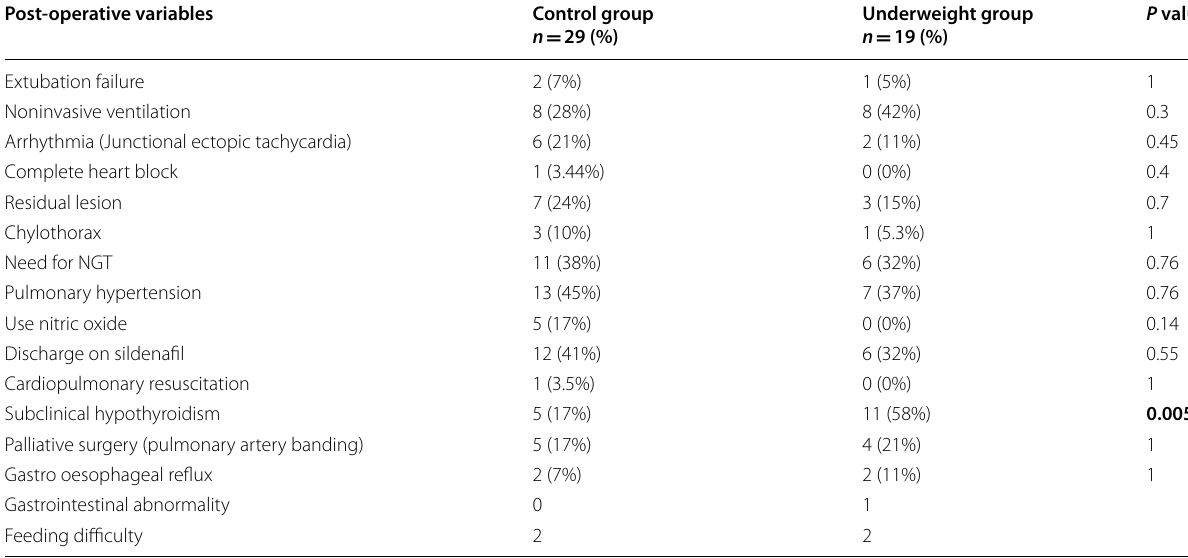
Bold indicate statistically significant p less than